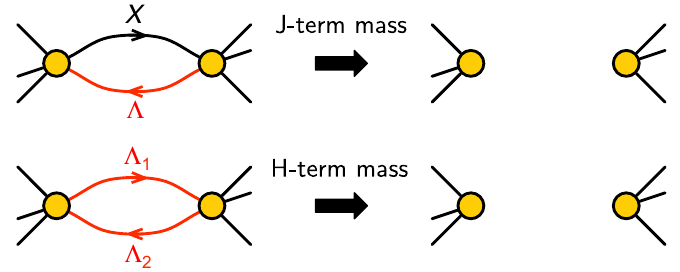
Figure 1 . Two types of mass terms in an N = 1 matrix